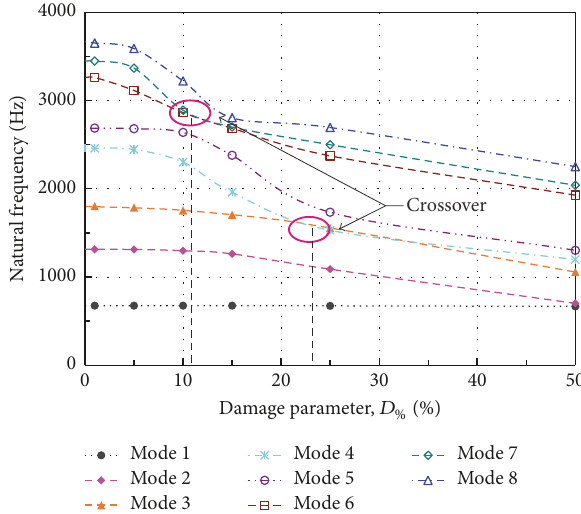
Figure 15: The influence of the debonding size on the natural frequencies